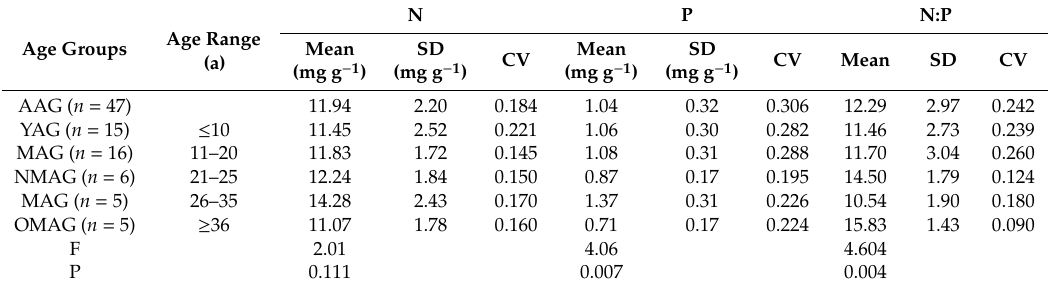
Table 1. Leaf nitrogen (N) and phosphorous (P) concentrations and N:P ratio for Chinese fir. Age Groups